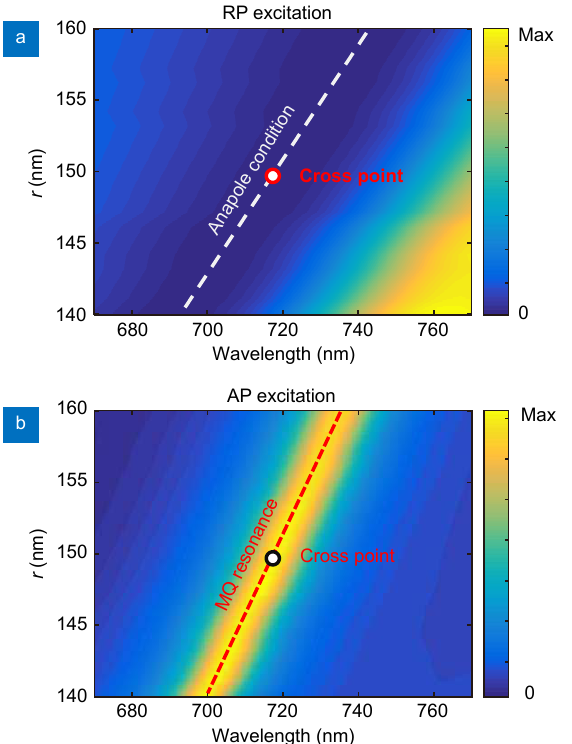
Fig. 4 | Evolution of the total scattering spectra for the Si nanodisk with different radius under the excitation of RP ( a ) and AP ( b ) beams with fixed focusing properties. The dependence of the anapole condi- tion and MQ resonance on the radius of the Si nanodisk are outlined by dashed lines. The NA and magnification factor of the objective lens are 0.95 and 60, respectively.